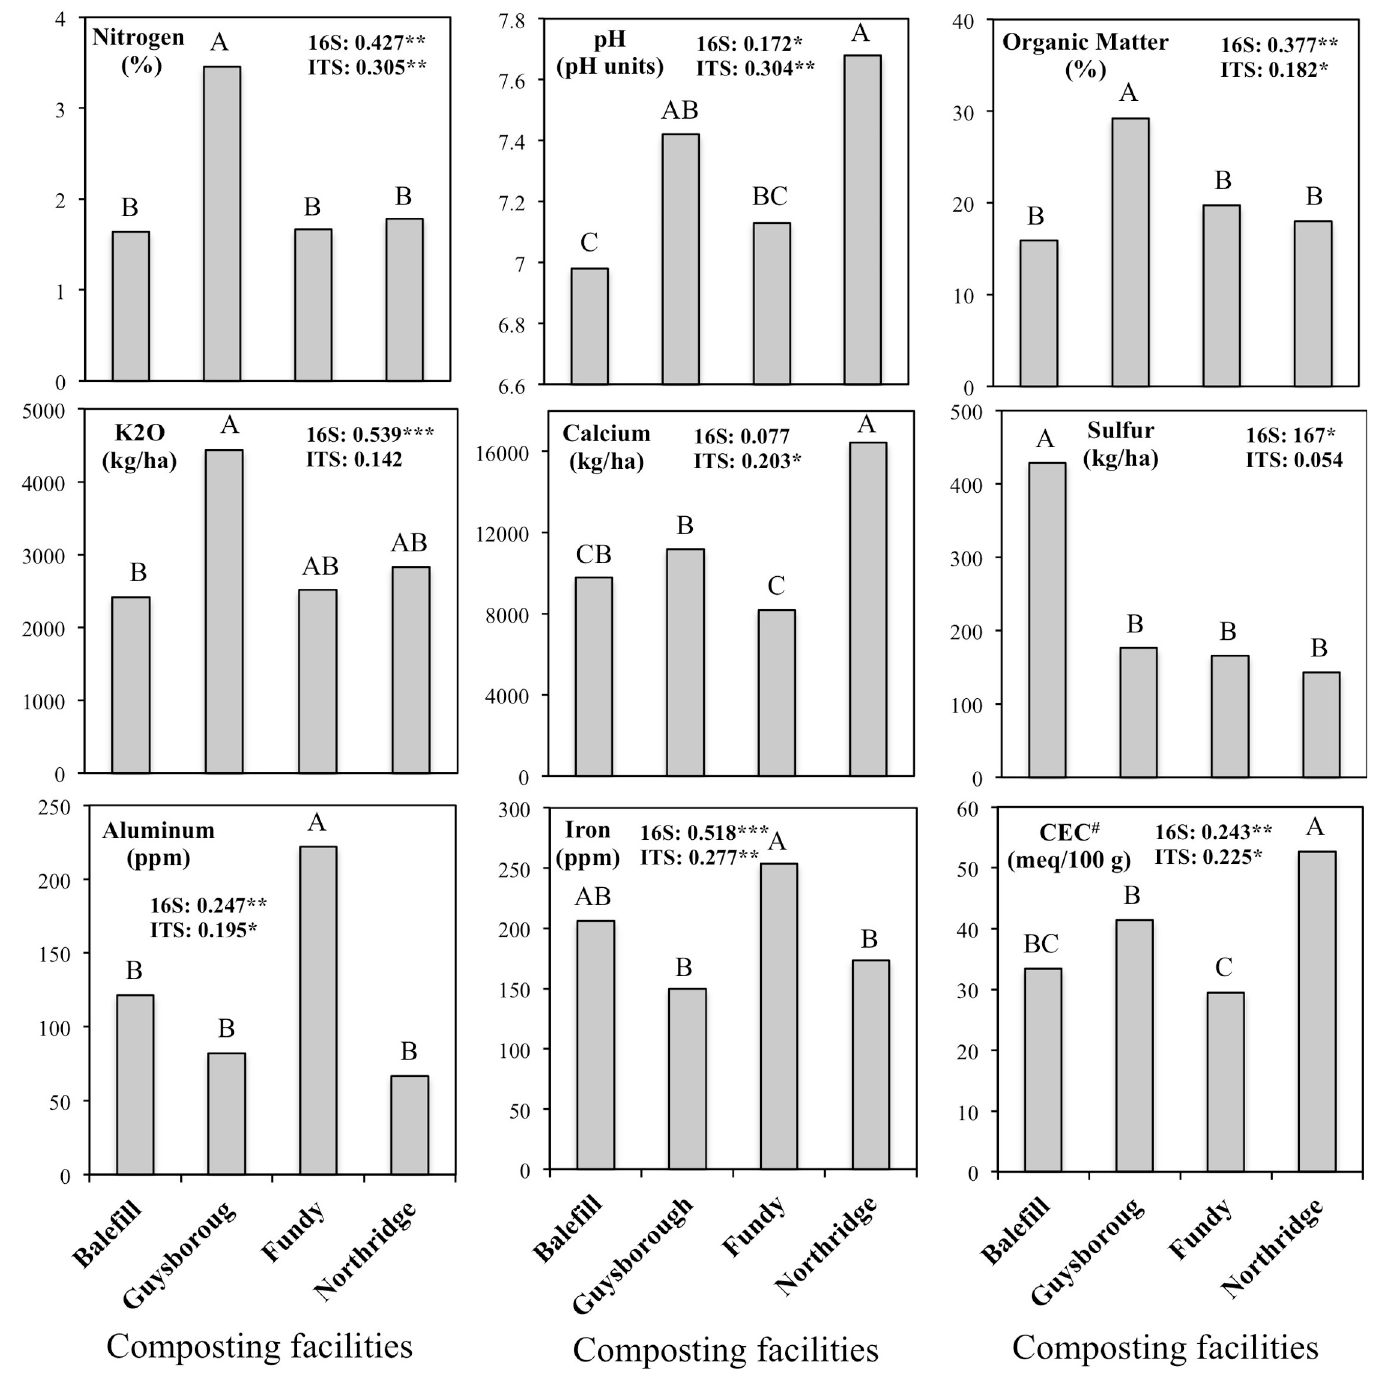
Fig 4. Mean soil chemical parameters and correlations between community structure and soil factors dissimilarity matrices. For each variable, data followed by different letters are significantly different according to Tukey’s test (P < 0.05). Adonis tests were used to assess whether beta-diversity is related to chemical soil factors, 999 permutations, R2, � p < 0.05; �� p < 0.01, ��� p < 0.001. #–Cation-exchange